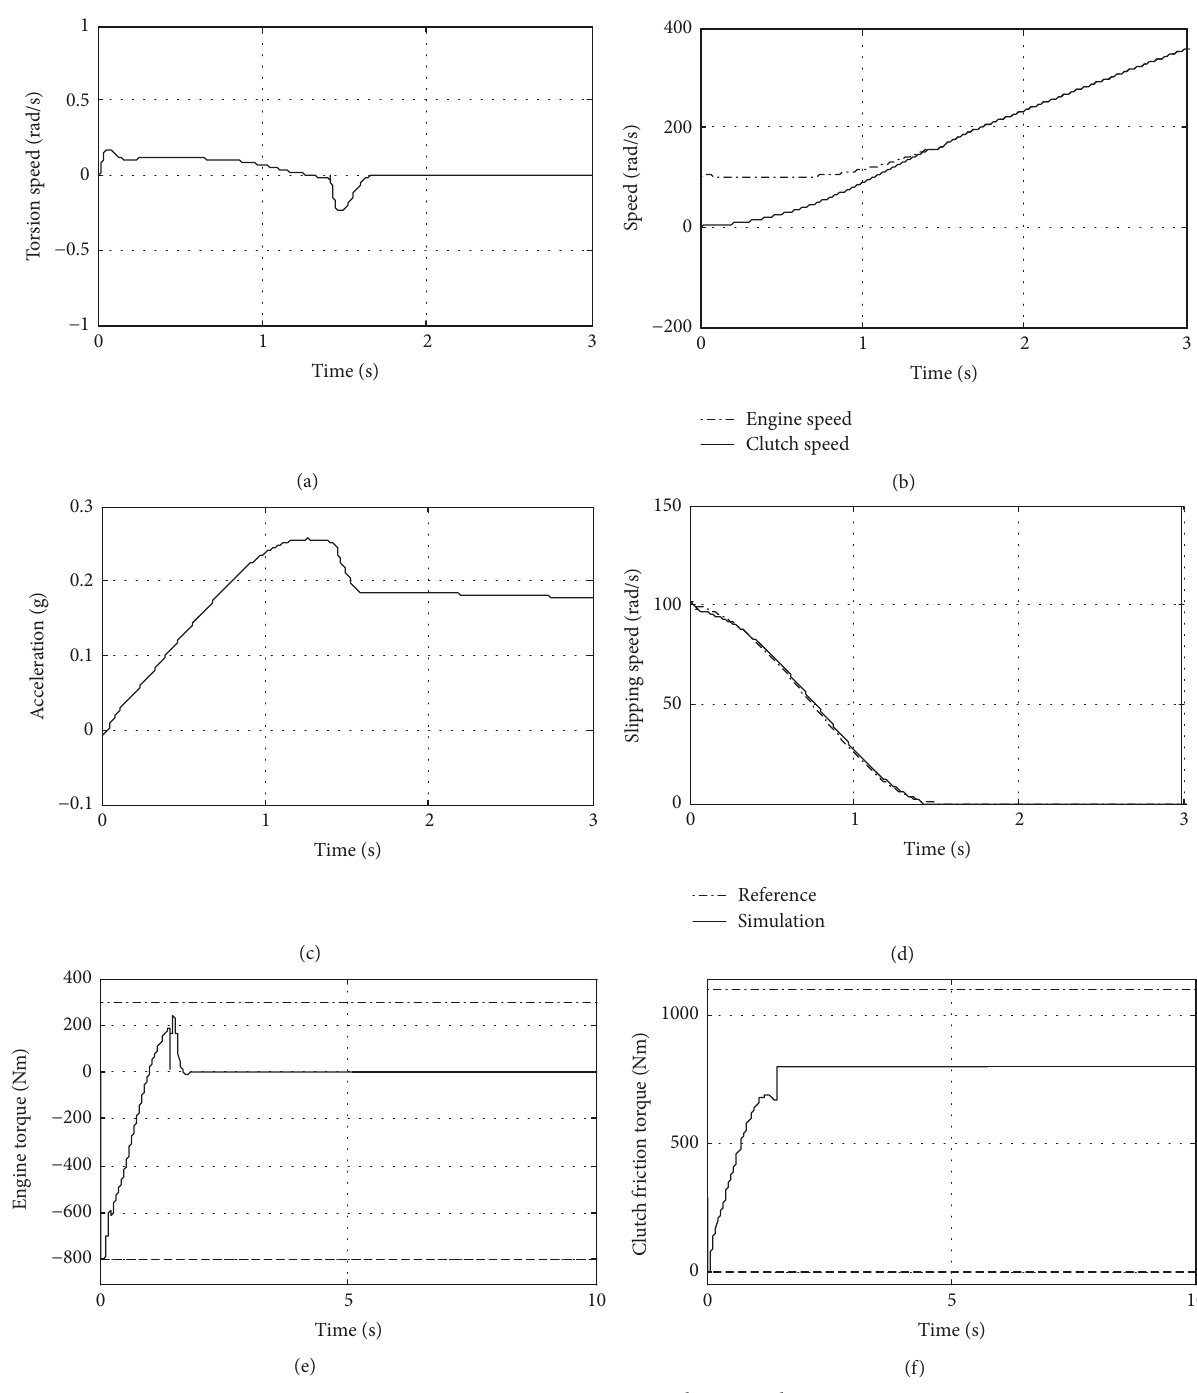
Figure 11: M4 maneuver simulation